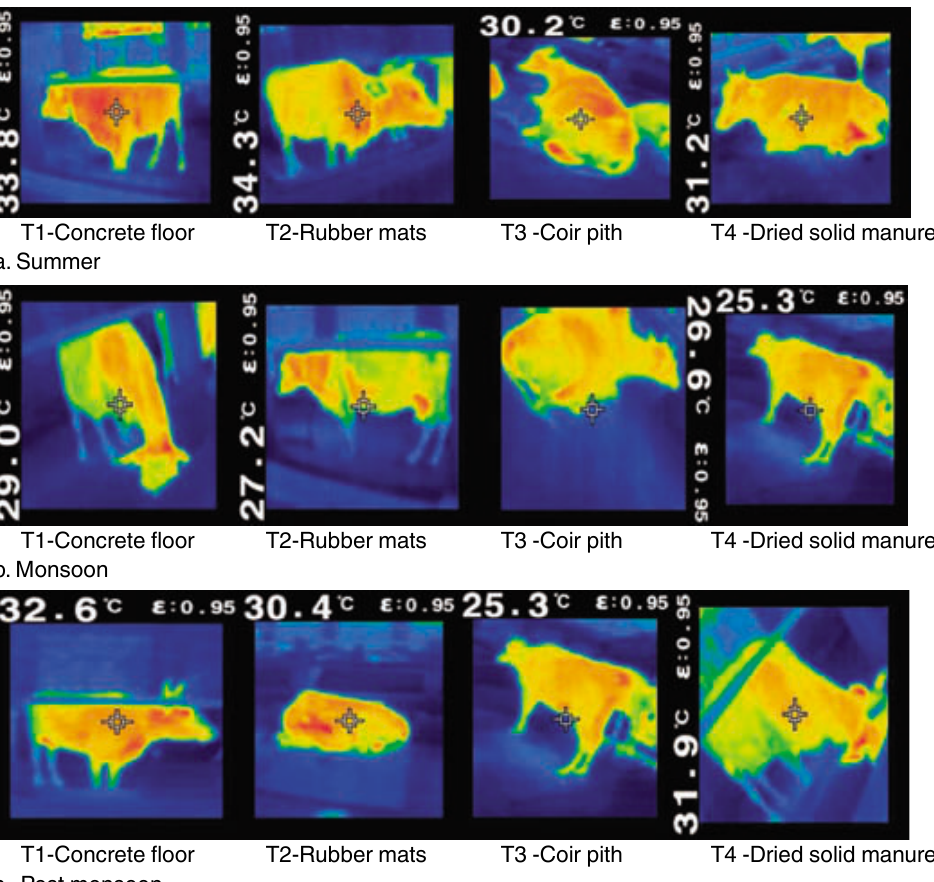
Fig. 1. Thermal images of cow body heat in different